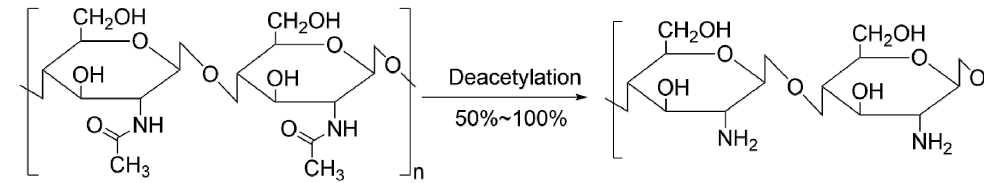
N -acetyl- d -glucosamine units converted to d -glucosamine Figure 1. Structure of chitin and chitosan N -acetyl- D -glucosamine units converted to D -glucosamine Figure 1. Structure of chitin and chitosan through deacetylation. When the percentage of d -glucosamine to total monomers reaches or surpasses 50%, we can define the copolymer chitosan; otherwise, it remains